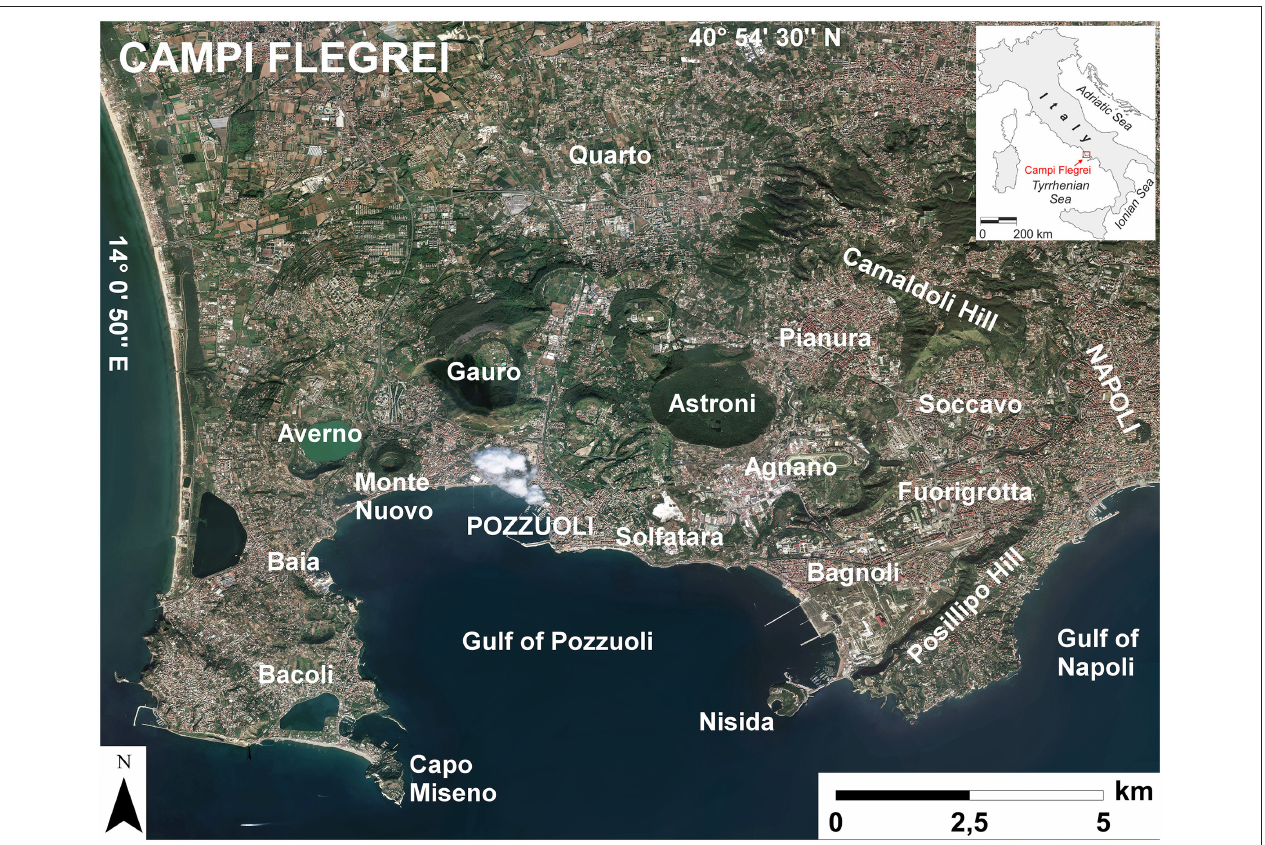
FIGURE 1 | Mosaic of aerial/satellite photos of Campi Flegrei caldera and surrounding areas (including part of the city of Napoli on the east) showing the large urbanization inside and around this active volcano, modified from the ESRI dataset World_Imagery